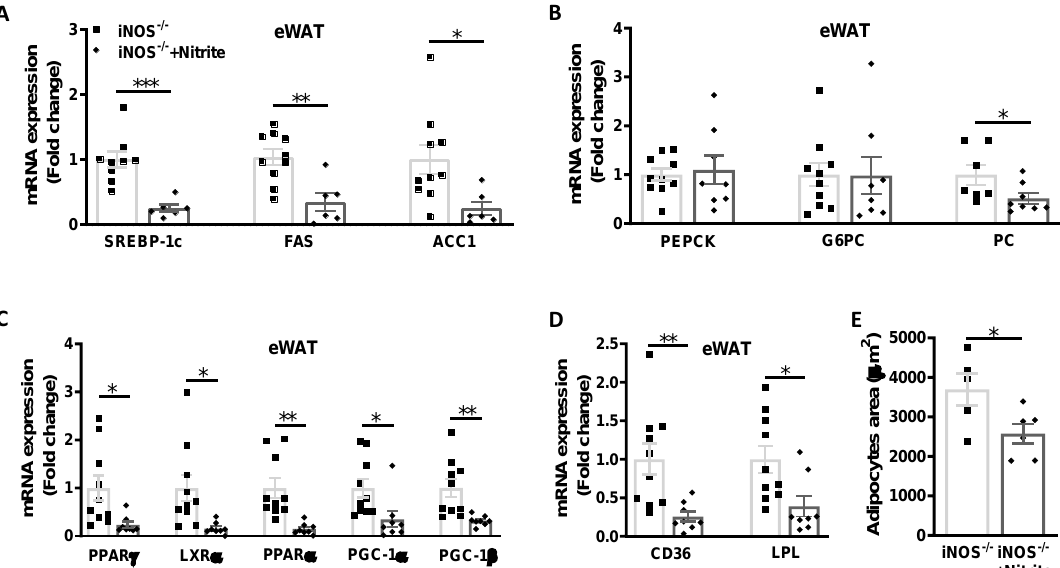
Figure 5. Metabolic homeostasis in adipose tissue of chow fed WT and iNOS − / − mice with and without nitrite supplementation. ( A ) qPCR expression of genes involved in lipid synthesis (iNOS − / − : n = 10, iNOS − / − + Nitrite: n = 6): SREBP-1c, FAS, and ACC1. ( B ) qPCR expression of genes involved in gluconeogenesis (iNOS − / − : n = 10, iNOS − / − + Nitrite: n = 8): PEPCK, G6PC, and PC (iNOS − / − : n = 7, iNOS − / − + Nitrite: n = 8). ( C ) qPCR expressions of transcriptional regulators involved in lipid synthesis (iNOS − / − : n = 10, iNOS − / − + Nitrite: n = 8): PPARy and LXR α and genes involved in fatty acids oxidation: PPAR α , PGC-1 α , and PGC-1 β . ( D ) qPCR expression of genes involved in lipid uptake (iNOS − / − : n = 10, iNOS − / − + Nitrite: n = 8): CD36 and LPL. ( E ) Mean adipocyte area (iNOS − / − : n = 5, iNOS − / − + Nitrite: n = 6) in chow fed iNOS − / − mice with or without nitrite supplementation. Data are represented as mean ± SEM. Black squares: iNOS − / − mice without nitrite supplementation, black diamonds: iNOS − / − mice with nitrite supplementation. * p < 0.05, ** p < 0.01, *** p < 0.001vs. iNOS − / − .